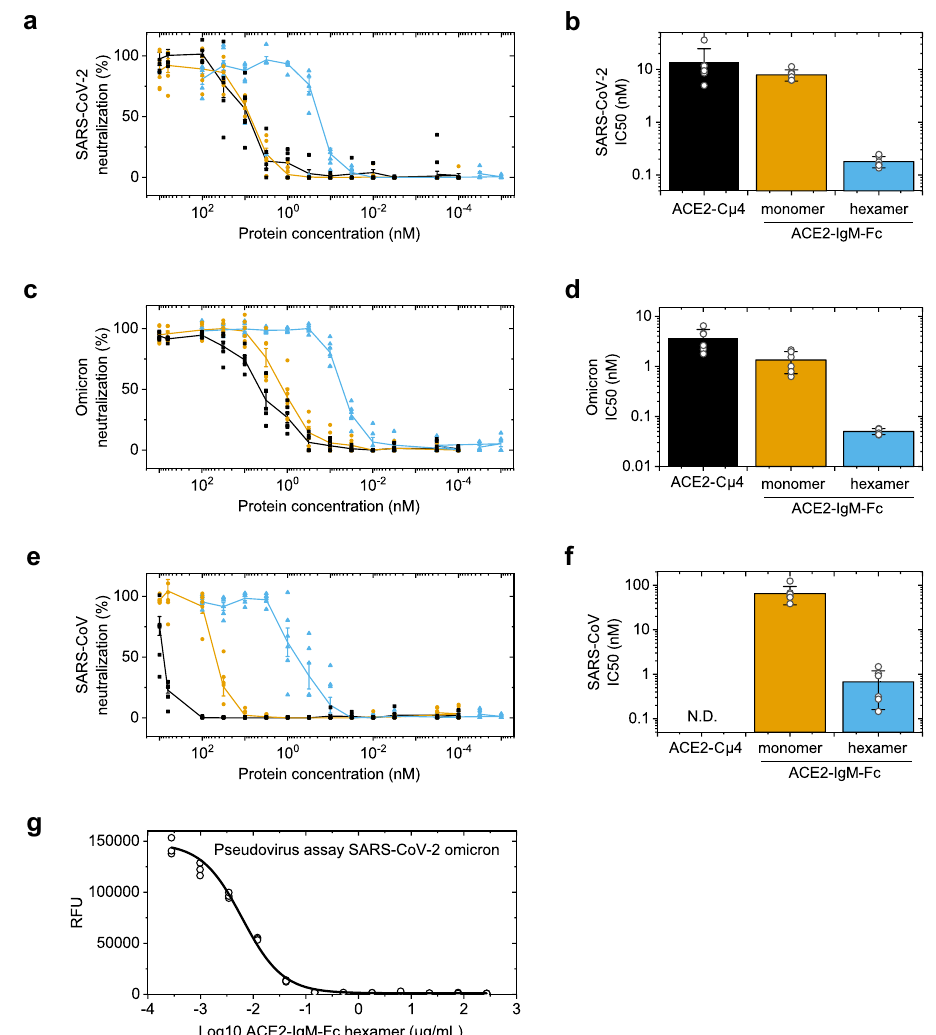
Fig. 4 Virus neutralization properties by the ACE2-fusions. a , c and e Virus neutralization of SARS-CoV-2, omicron and SARS-CoV by the ACE2-fusions. The values are mean values with standard error of the mean ( n = 6). Values from the individual replicates are shown. The lines are guide for the eyes. ACE2-C µ 4 (black squares), ACE2-IgM-Fc monomer (yellow circles), ACE2-IgM-Fc hexamer (blue triangles). b , d and f the corresponding IC50 values from the fi t to the virus neutralization data. Mean values with standard deviation ( n = 6). g Neutralization ef fi ciency of ACE2-IgM-Fc hexamer in a commercial pseudovirus assay with the omicron variant. The IC50 from the fi t is 6.6 ng/mL (95 % con fi dence interval 5.7 to 7.6 ng/mL). Individual values of triplicates.